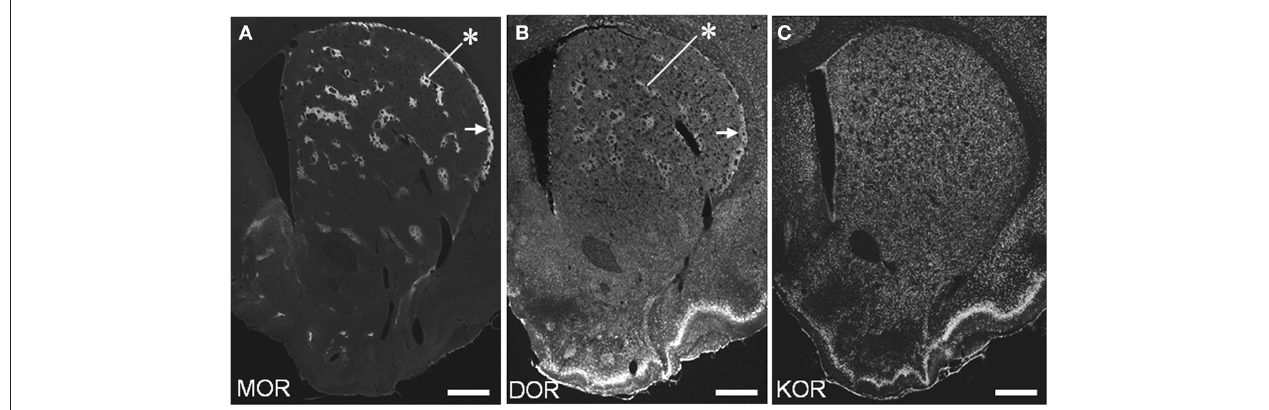
FIGURE 2 | Distributional patterns of MOR, DOR, and KOR in the striosome-matrix systems of the rat striatum. Single-label TSA immunostaining of the striatum using the antibody against MOR